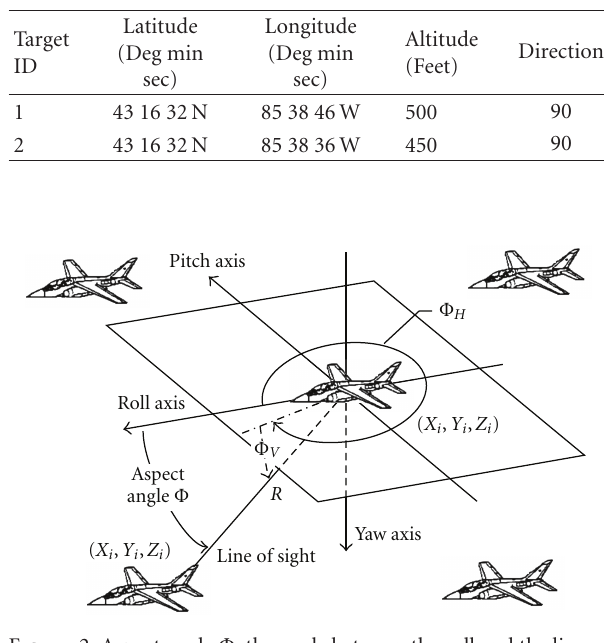
Table 1: Target information table.